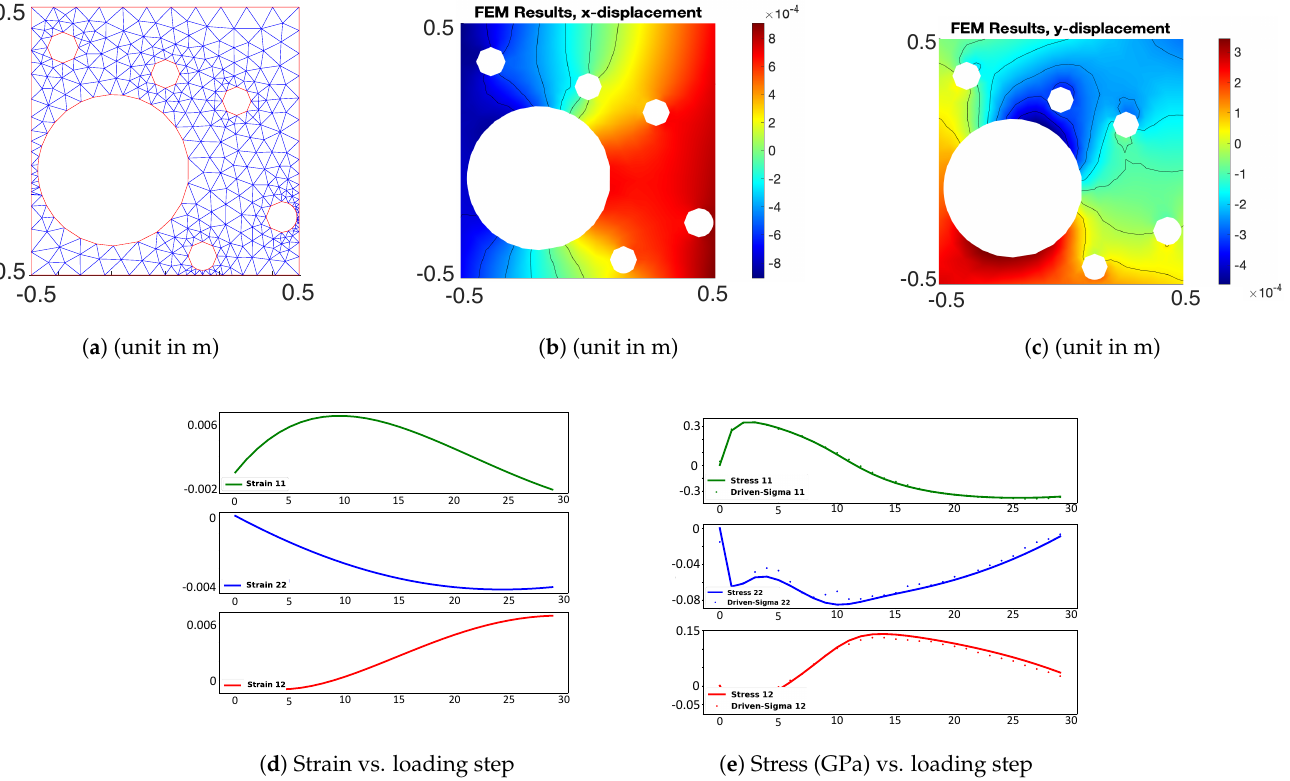
Figure 11. Test 1 for homogenization of nonlinear microstructure ( µ = 55 GPa and λ = 200 GPa), ( a ) FEM mesh, ( b ) X displacement (initial step), ( c ) Y displacement (initial step), ( d ) random generated strain, and ( e ) comparison of homogenized effective stress and data-driven